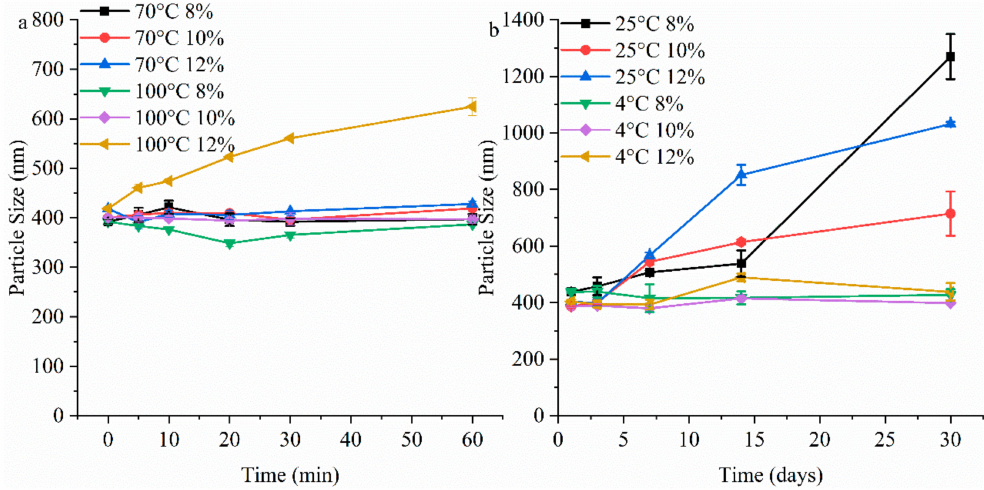
Figure 7. ( a ) The size of GNPs cross-linked by di ff erent genipin dosages (8–12 wt%) at di ff erent heating temperature (70 and 100 ◦ C) and time (0, 5, 10, 20, 30, and 60 min). ( b ) The size of GNPs cross-linked by di ff erent genipin dosages (8–12 wt%) at di ff erent storage temperature (25 and 4 ◦ C) and time (1, 3, 7, 14, and 30